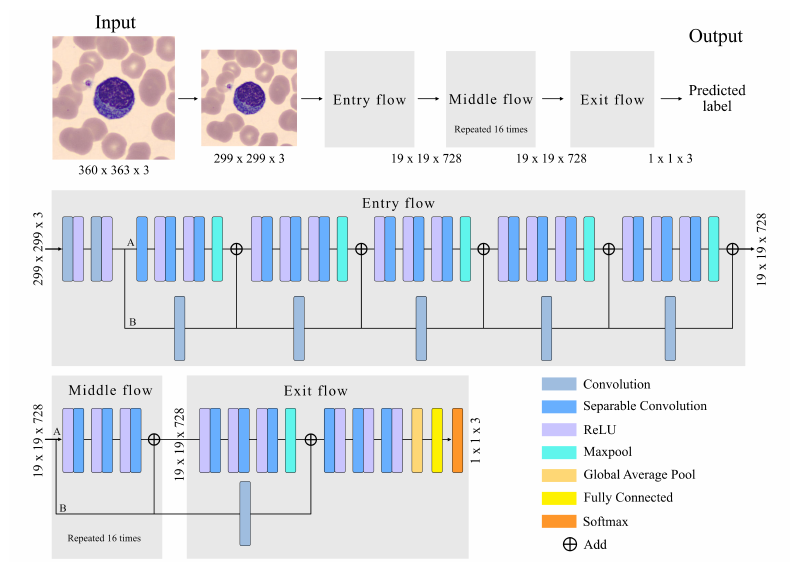
Figure 3. Model structure with 71 convolutions, 2 convolutions and 69 separable convolutions, a global average pool layer, a fully connected layer and a softmax output